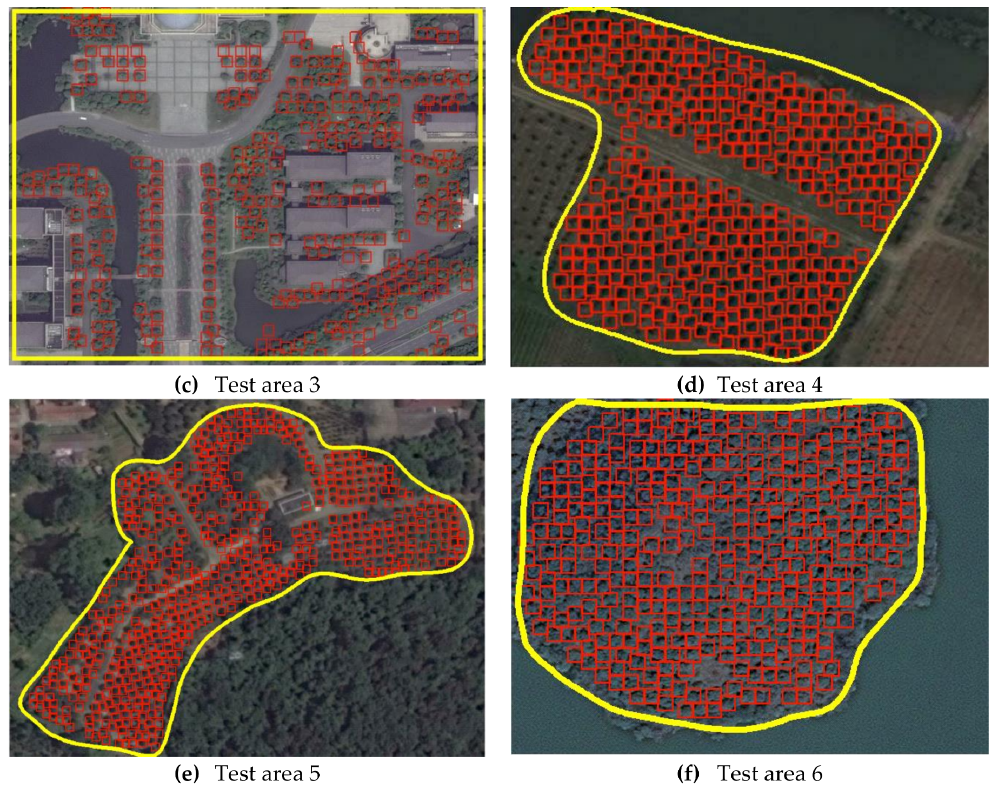
Figure 15. The detection result of each test area. The red rectangle represents a detected tree.